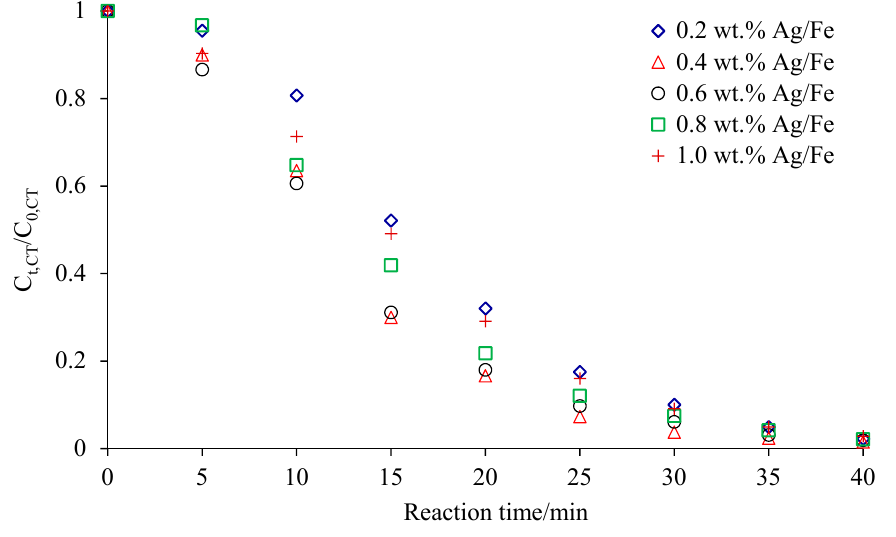
Figure 3. CCl 4 degradation by bimetallic Ag/Fe with different Ag loadings under the conditions of Ag/Fe dosage of 20 g/L, initial CCl 4 concentration of 20 mg/L, initial solution pH of 7, and stirring rate of 200 rpm.